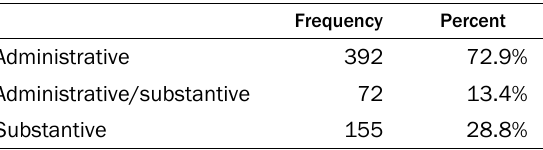
Table 3. Substantive versus Administrative Violations